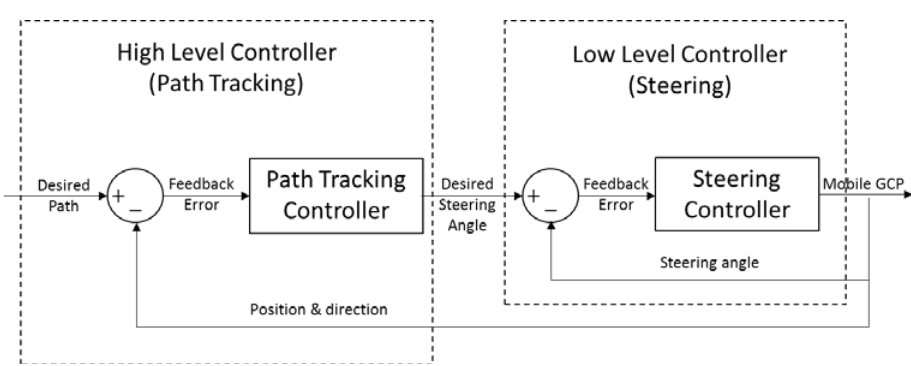
Figure 2. The architecture of the navigation control system, consisting of a high-level controller to regulate navigation and a low-level controller to regulate differential speed steering.